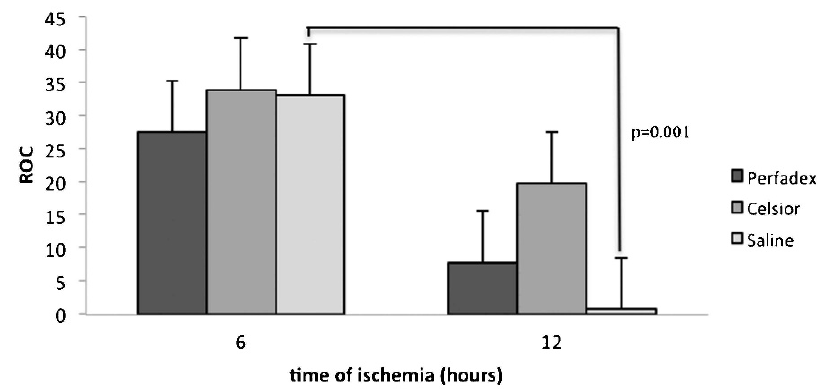
Figure 1 - Mean relative oxygenation capacity (ROC) of rat lungs subjected to ischemia and reperfusion for 60 minutes, illustrating no significant differences between Celsior- and Perfadex-perfused lungs at either ischemic time. The lungs subjected to 6 hours of cold ischemia exhibited higher ROCs than the 12-hour ischemic lungs, but this difference was significant only for the lungs preserved with saline ( p= 0.001).